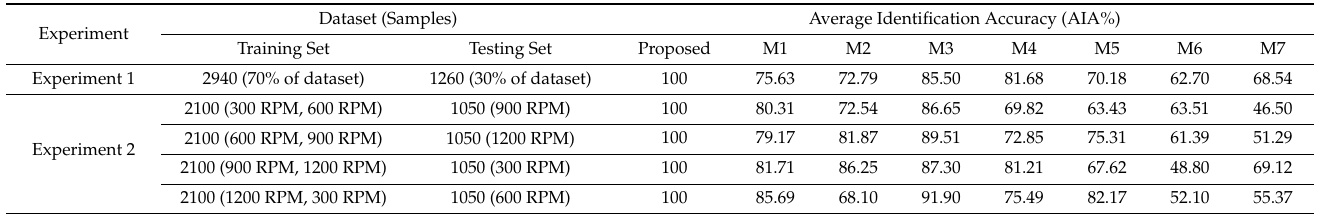
Table 4. Diagnostic performance results from the proposed and reference models in different